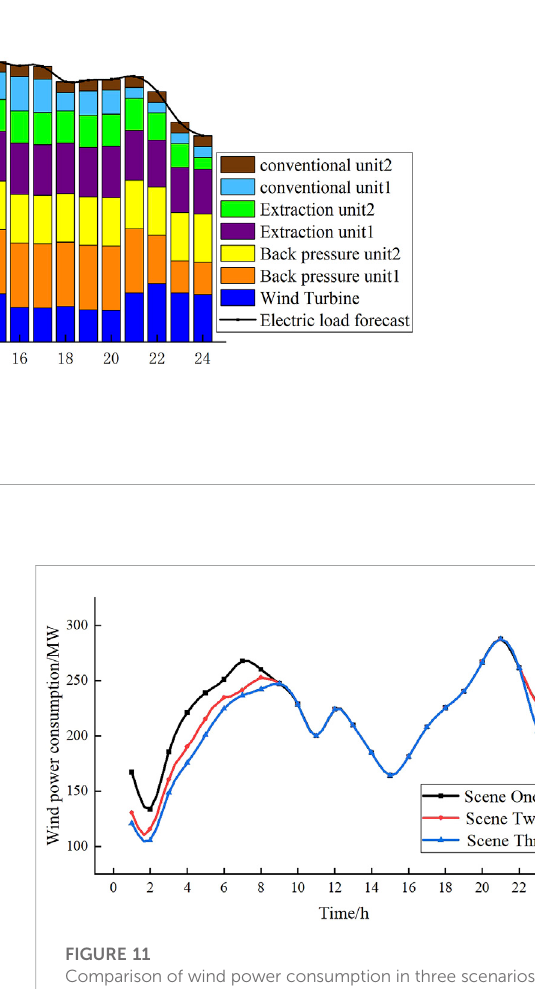
FIGURE 9 Cost comparison of the three scenarios.